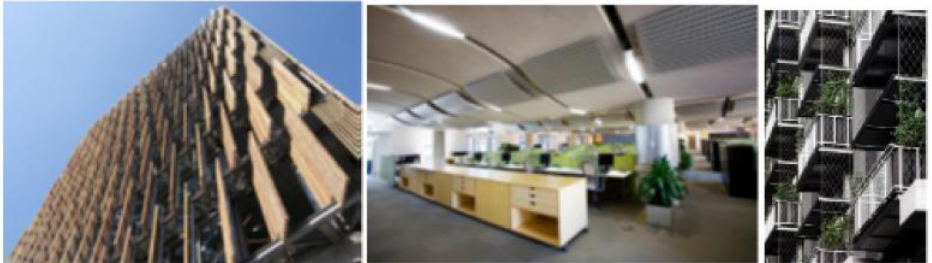
Fig. 6: the interior space of the building: right: the northern terraces - middle: office units - left: windows used for ventilation ( Meinhold,